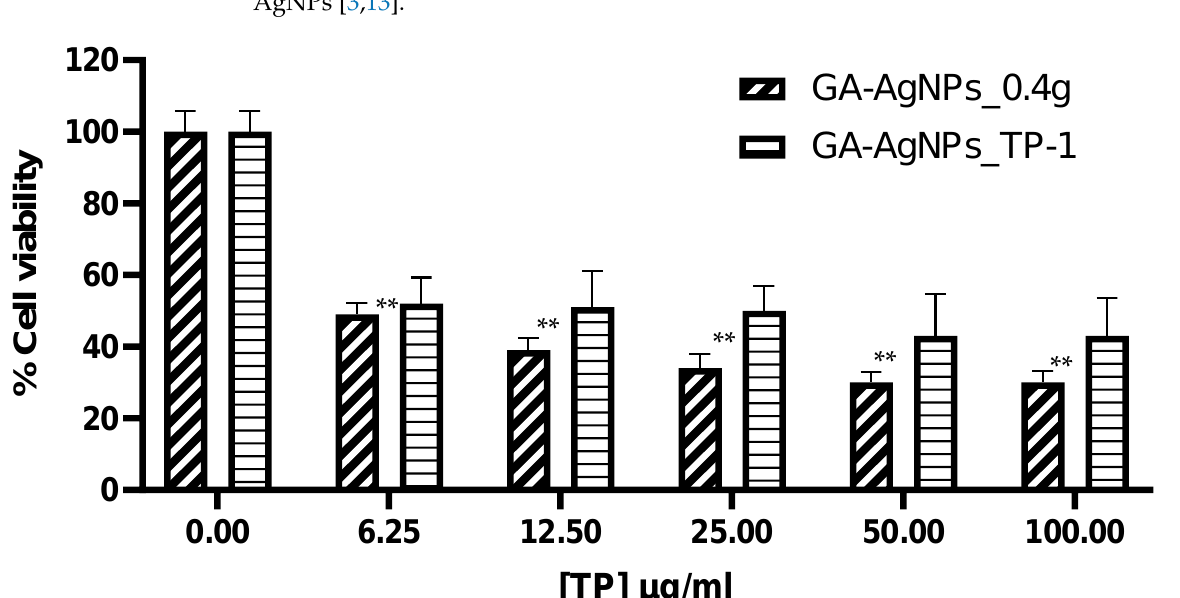
Figure 2. Cytotoxicity effects of GA-AgNPs_0.4g and GA-AgNPs_TP-1 on BMF cells. Cell viability was assessed by MTT assay after treatment for 24 h. p ≤ 0.05 was considered as statistically significant, ** p ≤ 0.01.